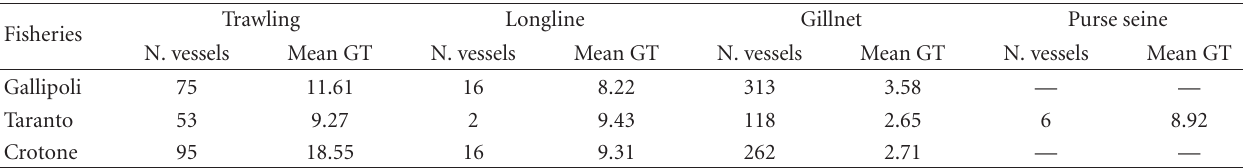
Table 1: Number of vessels and mean gross tonnage (GT) for di ff erent gears recorded in the main fisheries (Gallipoli, Taranto, and Crotone) of the north-western Ionian